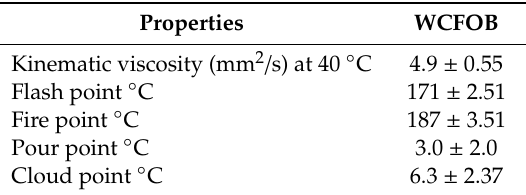
Table 5. Fuel characteristics of WCFO